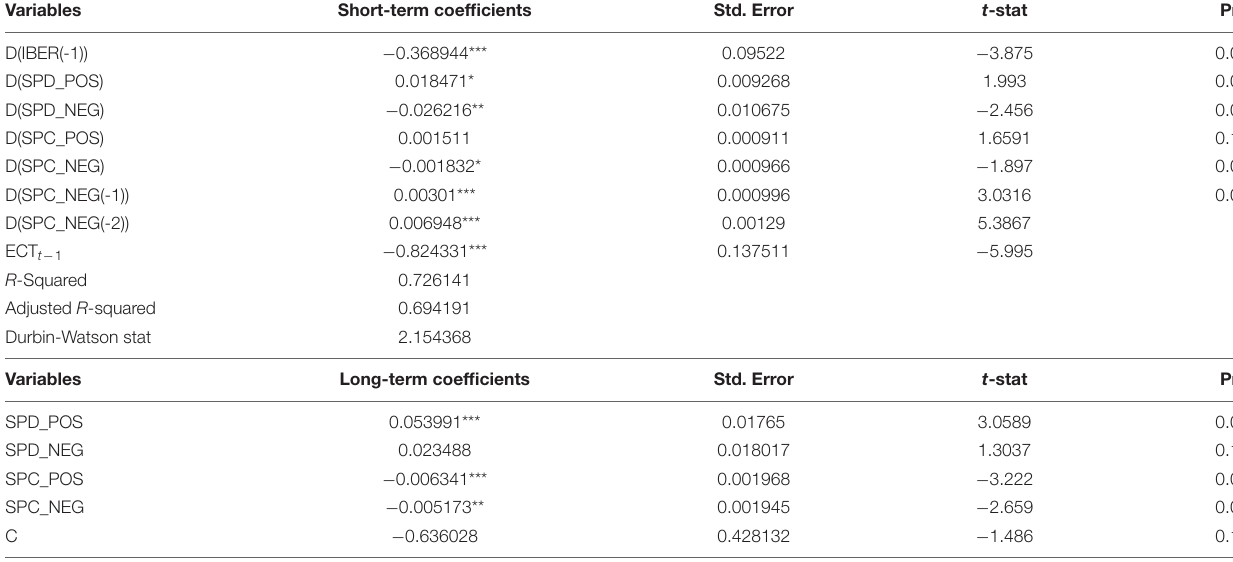
TABLE 7 | Asymmetric parameters of IBER.